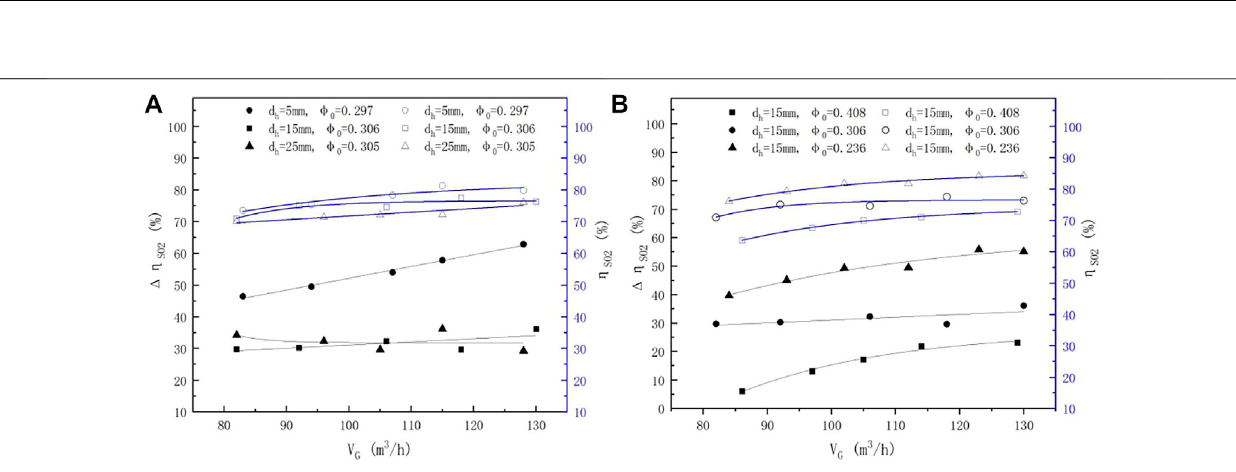
Frontiers in Energy Research |